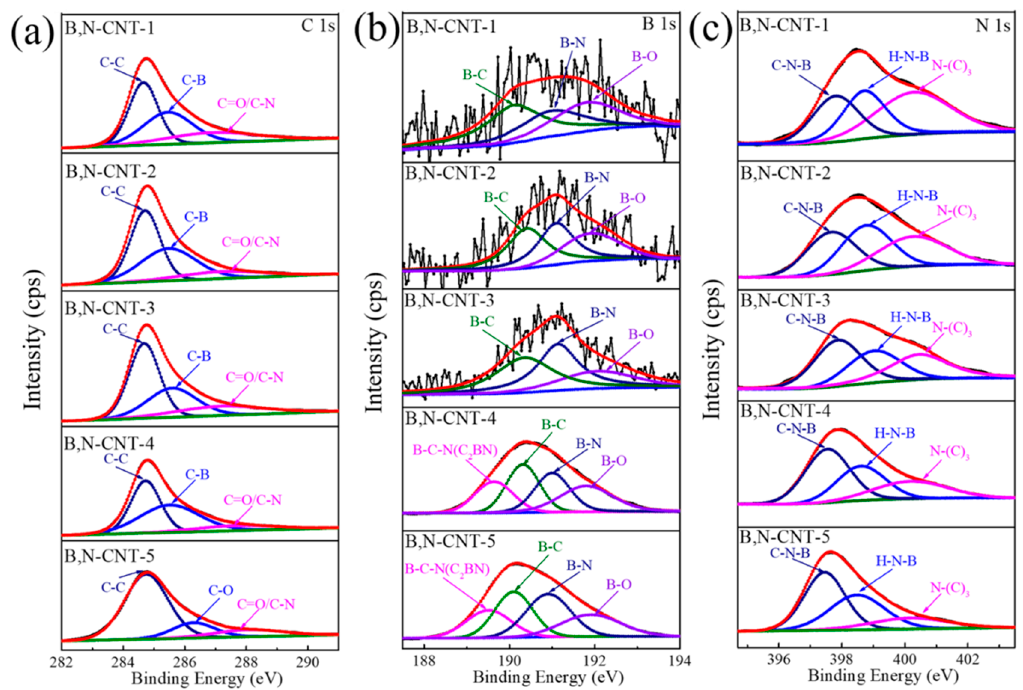
Figure 3. The ( a ) C 1s spectrum, ( b ) B 1s spectrum, and ( c ) N 1s spectrum of B,N-CNTs.